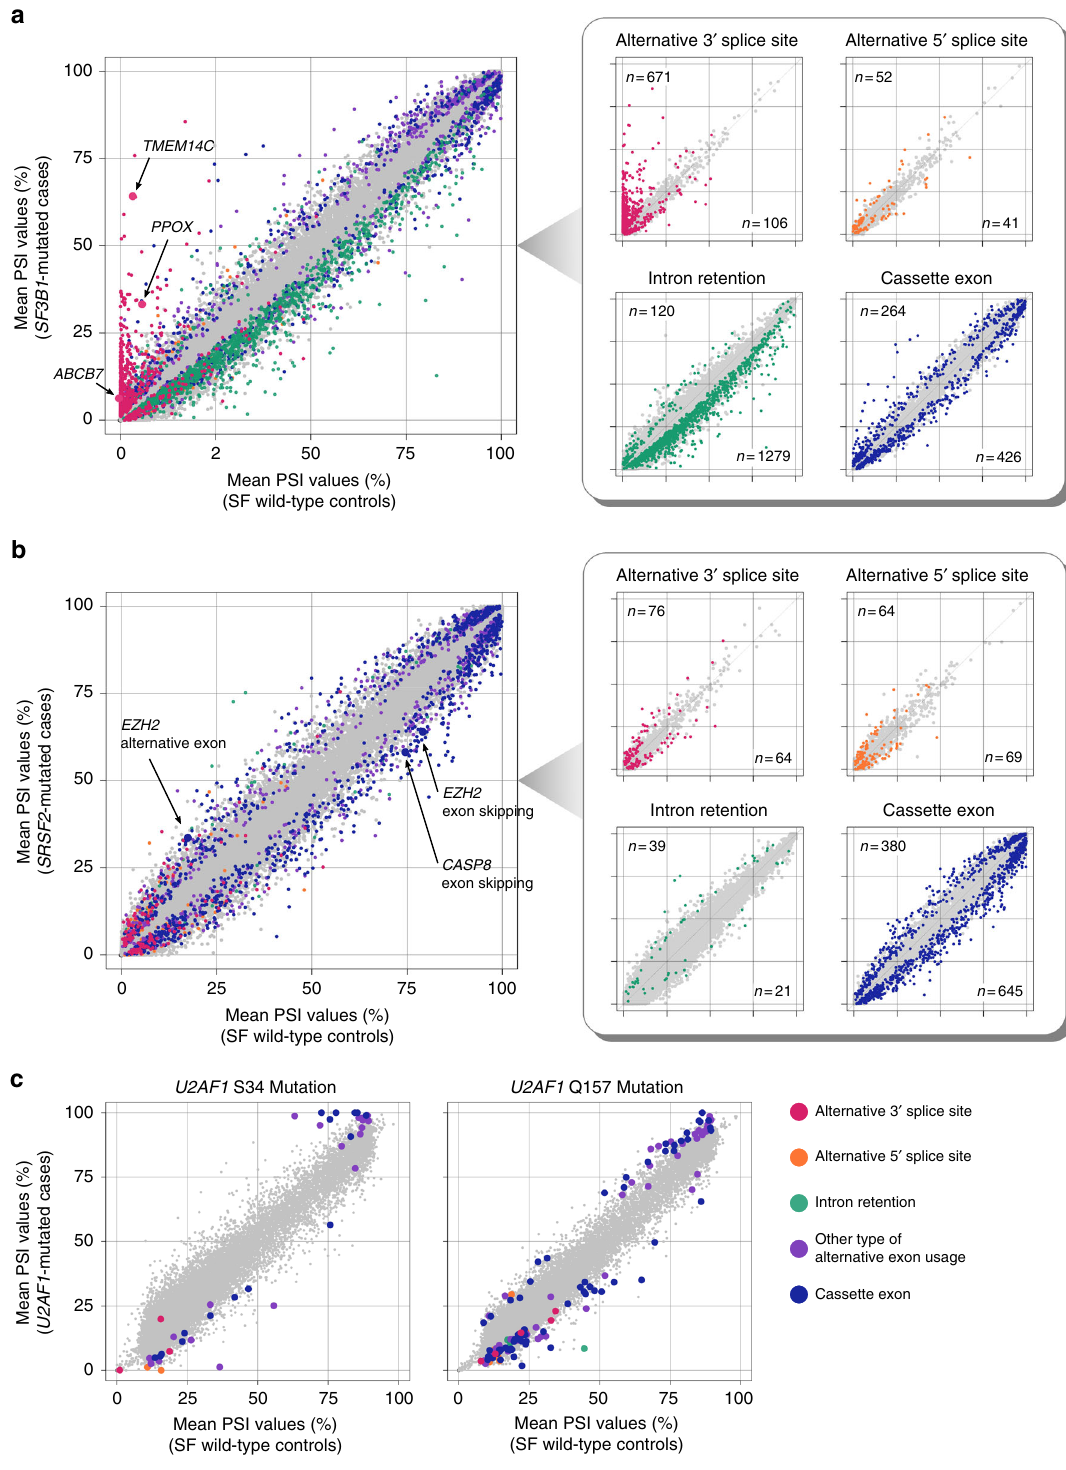
Fig. 2 Alternative splicing events associated with spliceosome mutations. a , b , c Scatter plots comparing mean PSI values between the SF3B1 - ( a ), SRSF2 - ( b ), and U2AF1 -mutated samples ( c ), and those without SF mutations. The number of samples in each group is shown in Fig. 1c. Signi fi cantly associated events ( q -value <0.01) are color coded as in the bottom right panel. The panels in the right are scatter plots for each splicing pattern, also showing the number of signi fi cant events. Other types of alternative exon usage included mutually exclusive exons, alternative fi rst exon, and alternative last